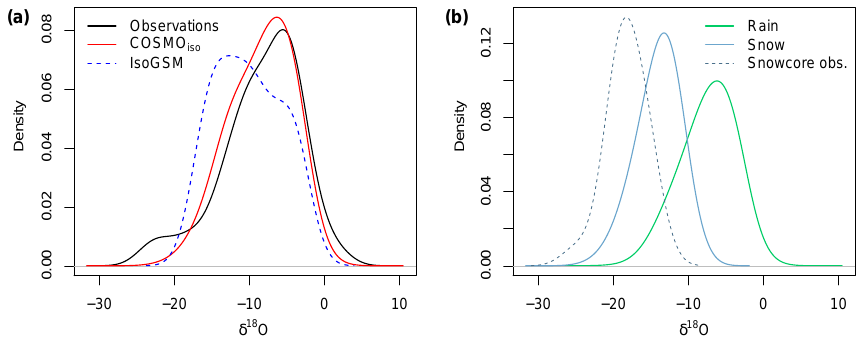
Fig. 4. (a) Probability density functions of δ 18 O (in ‰) in three-hourly accumulated precipitation from observations by GL90 (black line) and the COSMO iso reference simulation (red line). At a few stations where only six-hourly observations are available, these data are used. The blue dashed line shows the PDF of six-hourly data from an IsoGSM simulation. Model data from all land grid points between 28 ◦ N and 45 ◦ N latitude (for COSMO iso and IsoGSM) as well as 105 ◦ W and 60 ◦ W longitude (for IsoGSM) are taken into account. Note that no weighting with precipitation intensity is performed. The PDFs have been fitted with a non-parametric method using Gaussian kernels. (b) PDFs of δ 18 O in three-hourly rain (green line) and snow (blue line) from COSMO iso . The blue dashed line shows the PDF of snowcore data from